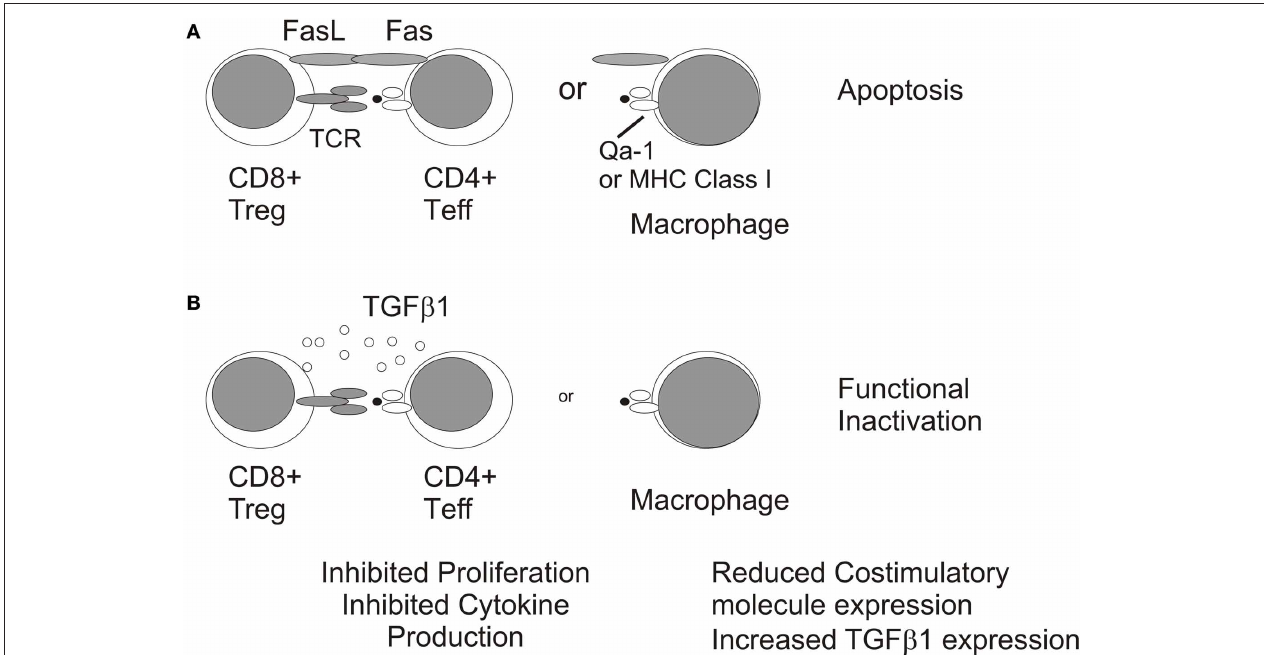
FIGURE 5 | Mechanisms of immunosuppression by CD8 + Treg. CD8 + Tregs may inhibit DTH responses by inducing apoptosis of CD4 + T cell effectors or macrophages (A) or by functionally inactivating these immune populations via TGFb1 expression (B)